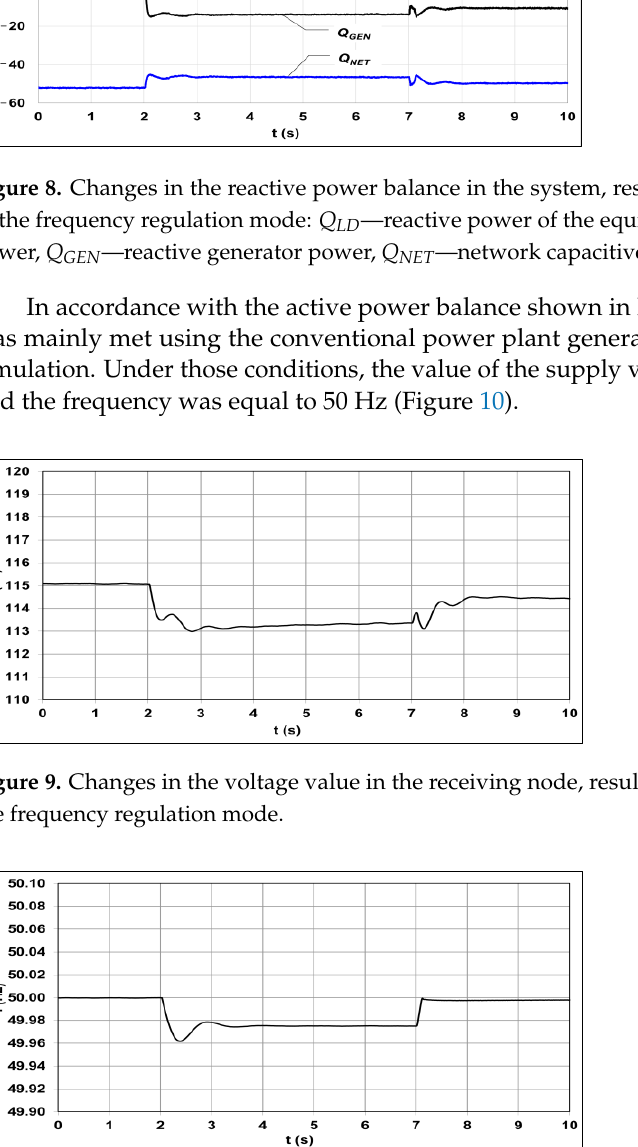
Figure 7. Changes in the active power balance in the system, resulting from the operation of the farm in the frequency regulation mode: P LD — active equivalent load power, P W F — active WF power, P GEN — active generator power, ΔP — active power losses in the network.